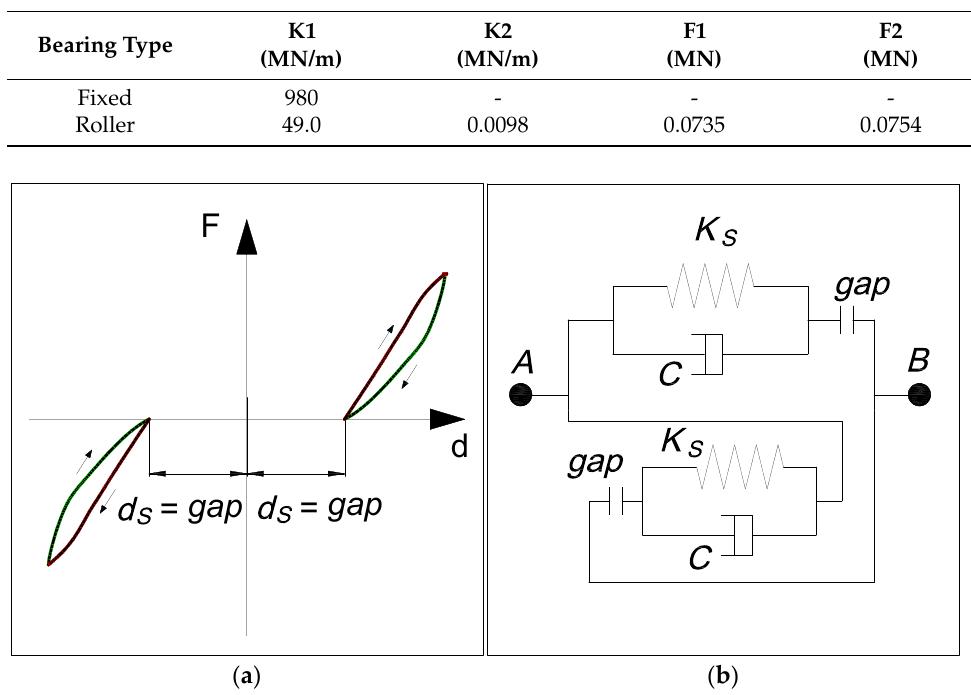
Figure 5. Force–displacement relationships for steel bearing supports. ( a ) Fixed bearing. ( b ) Roller bearing. Table 3. Structural properties of steel bearing supports.